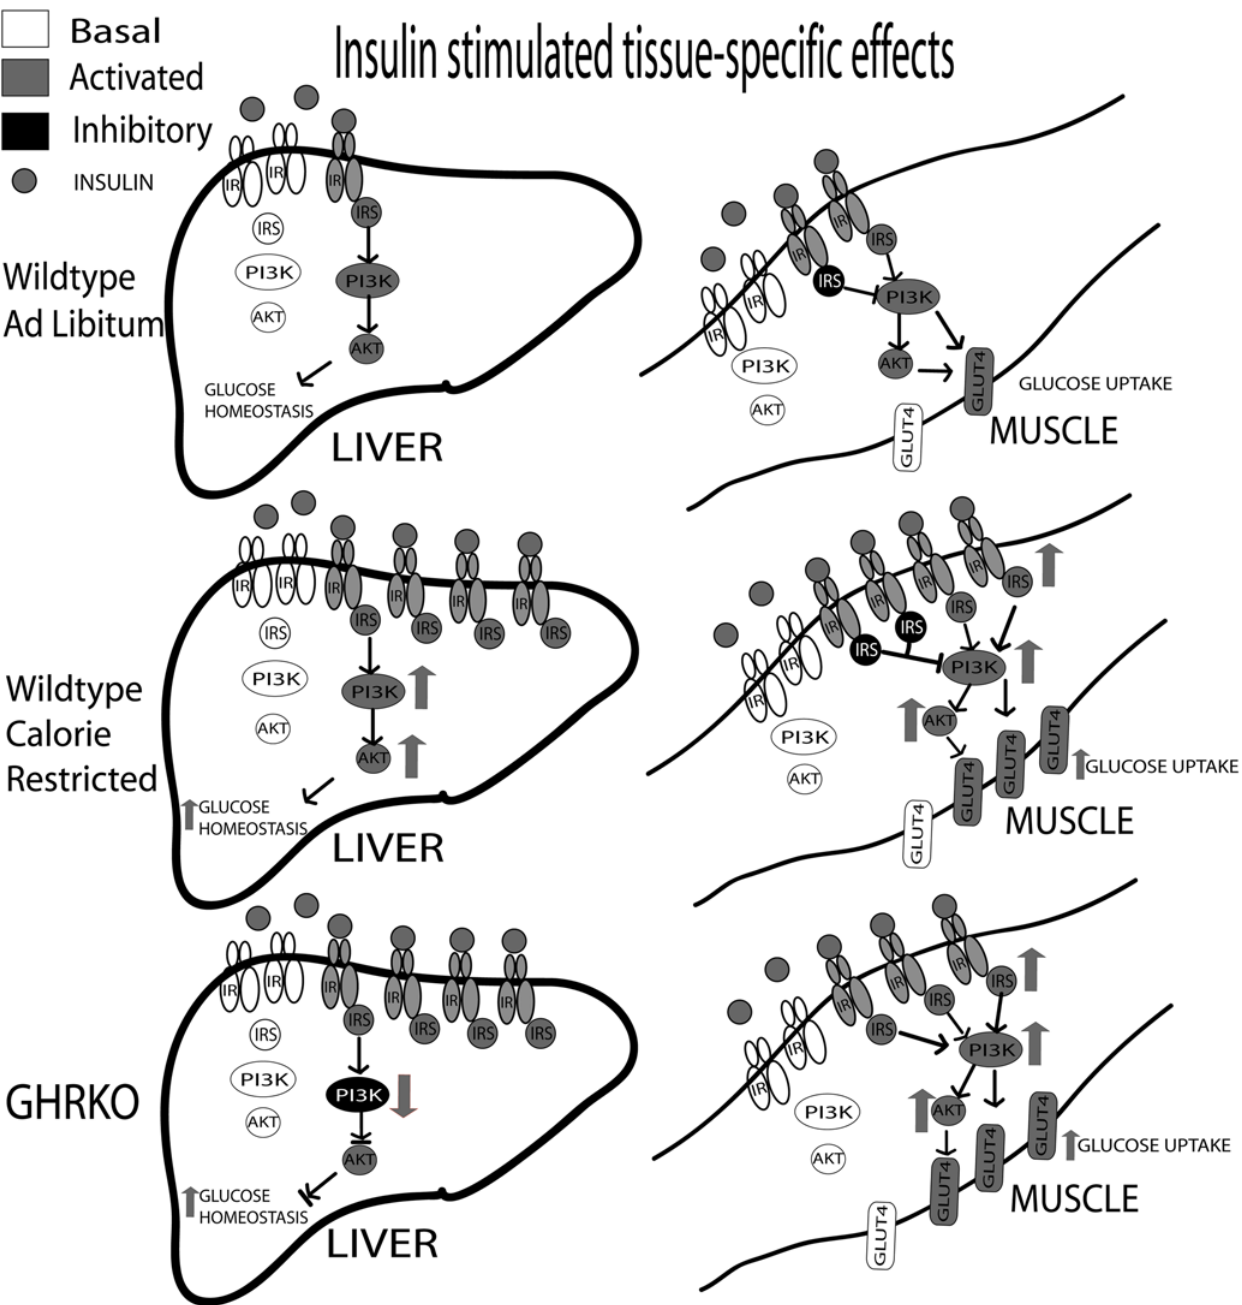
Figure 7. Summarizes the effects of CR, or lack thereof, in wildtype and GHRKO mice under insulin-stimulated conditions. Solid grey proteins represent stimulatory activation, while solid black proteins are